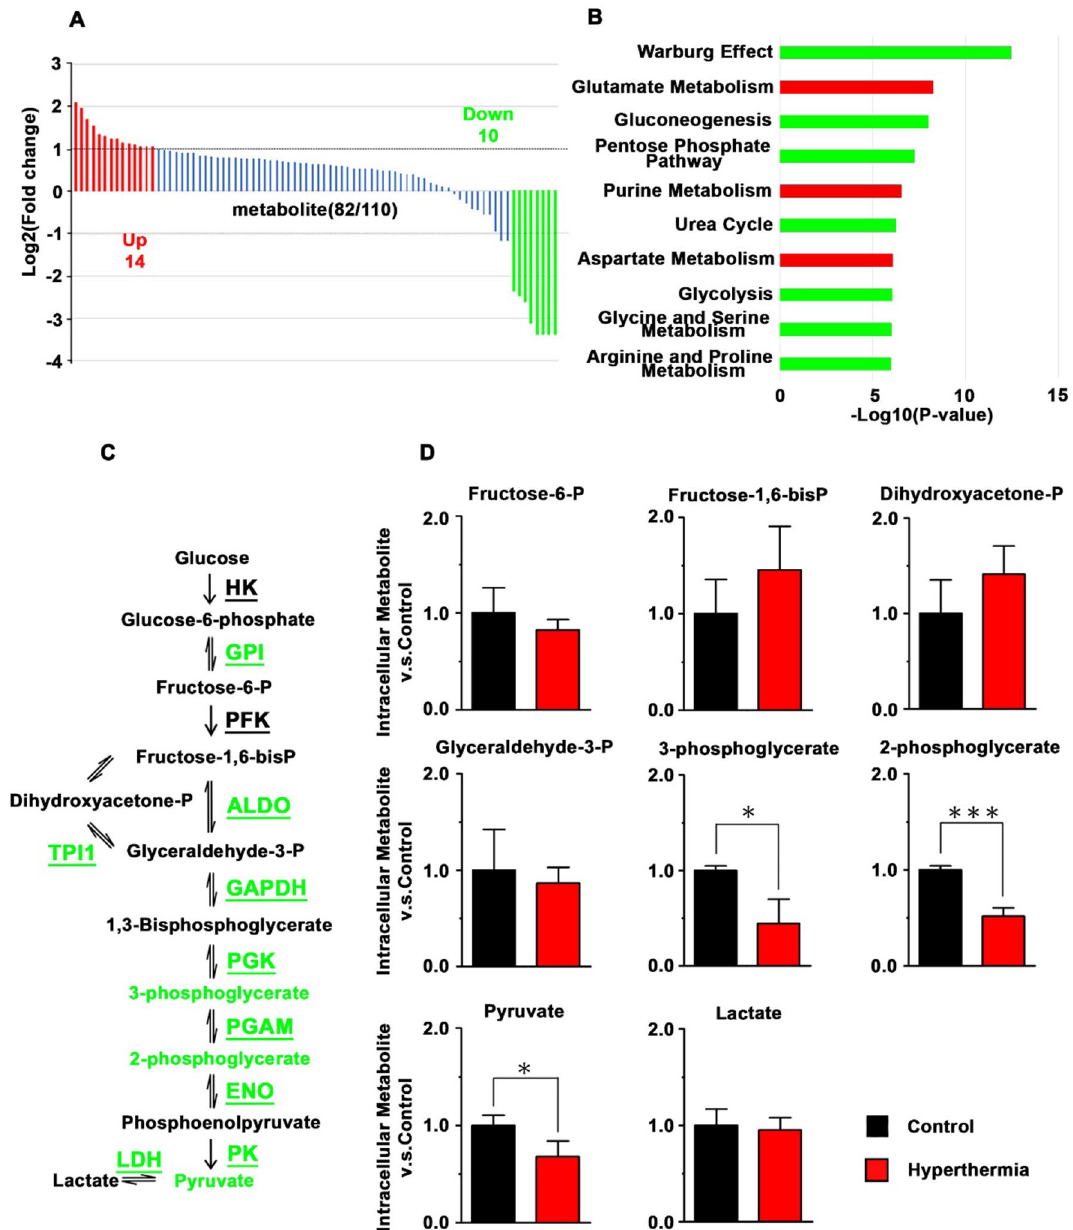
Figure 1. Analysis of Metabolites in heated SKOV3 cells. ( A ) Log2 fold change of metabolites in SKOV3 cells after hyperthermia, as compared to control SKOV3 cells. Significant change according to a fold change greater than 2 is indicated by colors (red: upregulated, green: downregulated). ( B ) Enriched metabolic pathways identified for the affected metabolites in SKOV3 after hyperthermia. Green and Red: Predicted as downregulated and upregulated pathways, respectively. ( C ) Schematic of the glycolysis pathway. Enzymes are underlined. Enzymes and metabolites highlighted in green represent downregulated proteins and metabolites in SKOV3 cells after hyperthermia. ( D ) Relative amounts of metabolites involved in glycolysis. Average ± S.D.; n = 3. *P < 0.05; ***P <